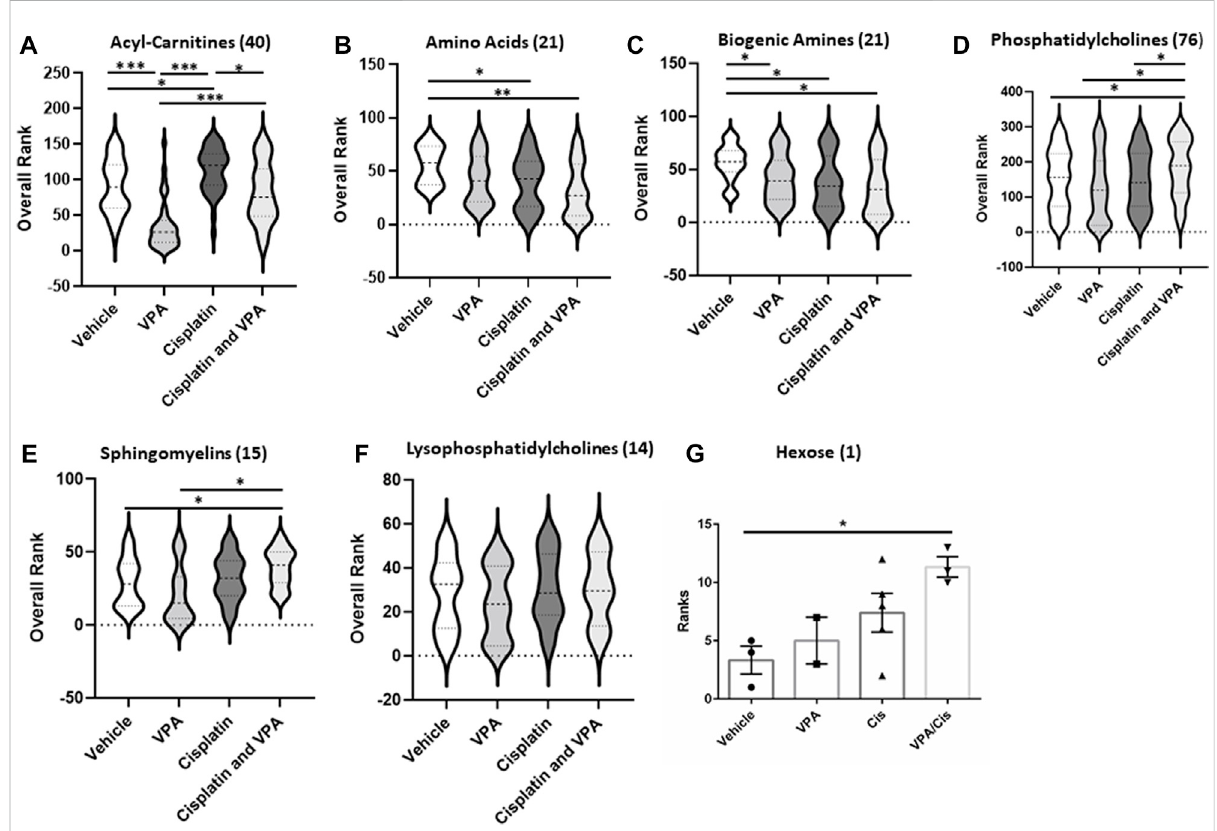
FIGURE 2 Metabolic subclass analysis of vehicle, VPA, Cisplatin and their combination treated MDA-MB-231 cells after 72 h. Pro fi ling data of overall rank: (A) Acyl-Carnitines, (B) Amino, (C) Biogenic Amides (D) Phosphatidylcholines, (E) sphingomyelins, (F) Lysophosphatidylcholines and (G) Hexose; n = 5. The number in the brackets represent the number of metabolites. The middle line in the violin is the mean rank. * p < 0.05, ** p < 0.001, *** p <